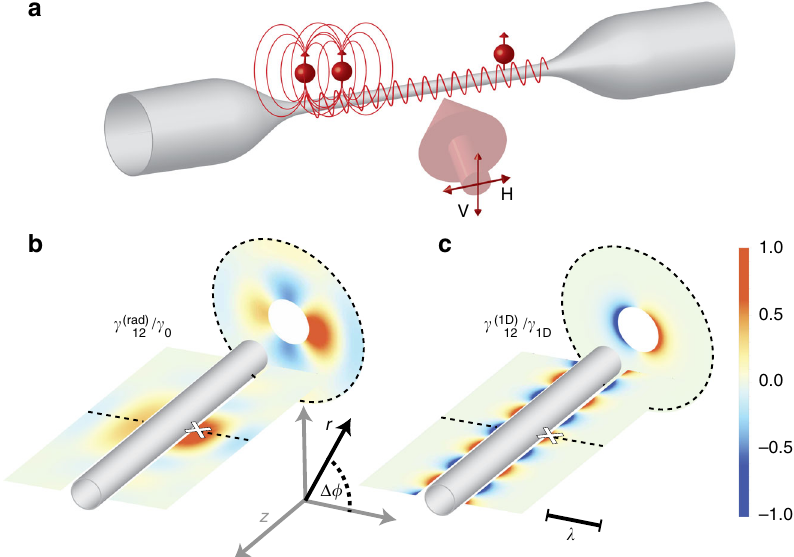
Fig. 1 Position-dependent atom – atom coupling along the optical nano fi ber. a Schematic of an ONF as a platform for generating single photon collective atomic states, excited from the side by a weak probe of polarization V or H. When two atoms are close together, the dipolar interaction is mostly mediated by the modes of the electromagnetic fi eld radiating outside the nano fi ber. This is a limited-range interaction that decays inversely with distance. When the atoms are widely separated, the guided mode of an ideal ONF mediates the interaction for arbitrary distances. b , c Show the atom – atom interaction rate γ 12 (see Eq. (4)) experienced by an atom around the fi ber given another atom at the position denoted by the white cross (see “ Methods ” section for the details of the calculation). Its amplitude is shown for a longitudinal and a transversal cut (speci fi ed by dashed black lines). Both plots share the color scale, but in b the interaction rate is normalized by the single atom total decay rate γ 0 and in c by the decay rate into the guided mode γ 1D . Along the z -axis, the interaction k Δ z j jð Þ = k Δ z (with k being the wavenumber and Δ z the separation between two among atoms through free space radiation modes decreases as γ ð rad Þ 12 / sin β Δ z ð Þ cos ð Δ ϕ Þ (with β atoms). The in fi nite interaction through the ONF-guided mode changes as γ ð 1D Þ 0 being the propagation constant of the 0 12 / cos resonant-guided mode and Δ ϕ the angle difference in cylindrical coordinates). The wavelength λ sets the scale in b ,